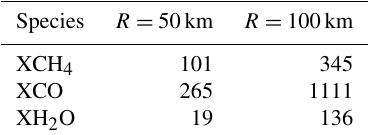
Table A2. Number of TROPOMI measurements within 50km and within